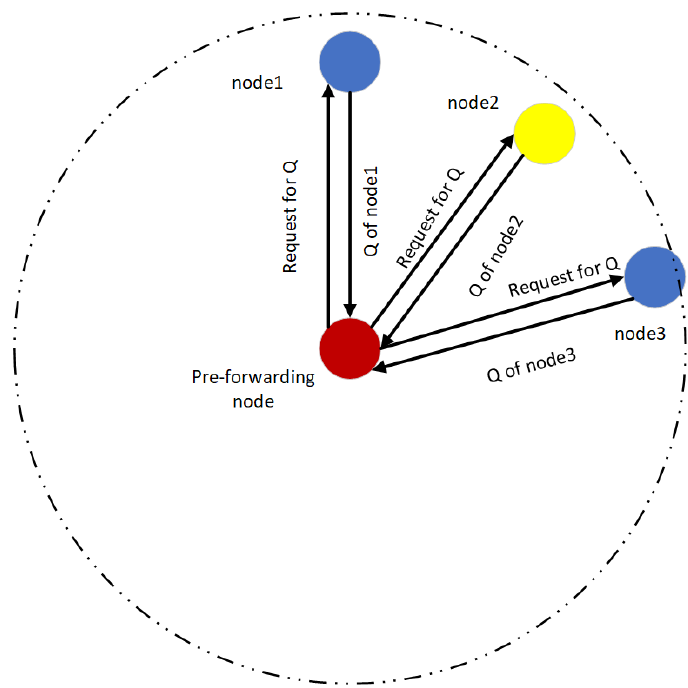
Figure 9. The schematic diagram of the Q value of pre-forwarding node